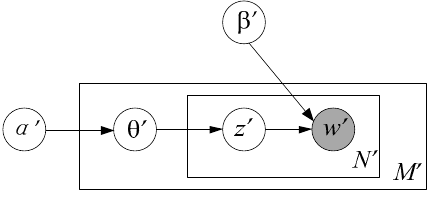
Figure 1. Graphical model representation of LDA.